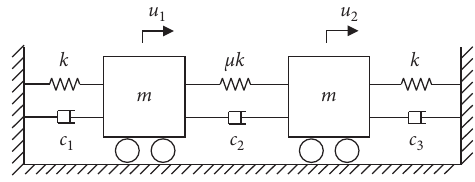
Figure 8: (a) Histogram of the randomly initialized center frequencies ω 1 different values of constraint parameter (b) α � 1e3, (c) α � 1e4, and (d) α � 1e5, where the Hurst exponent H � 0.2.